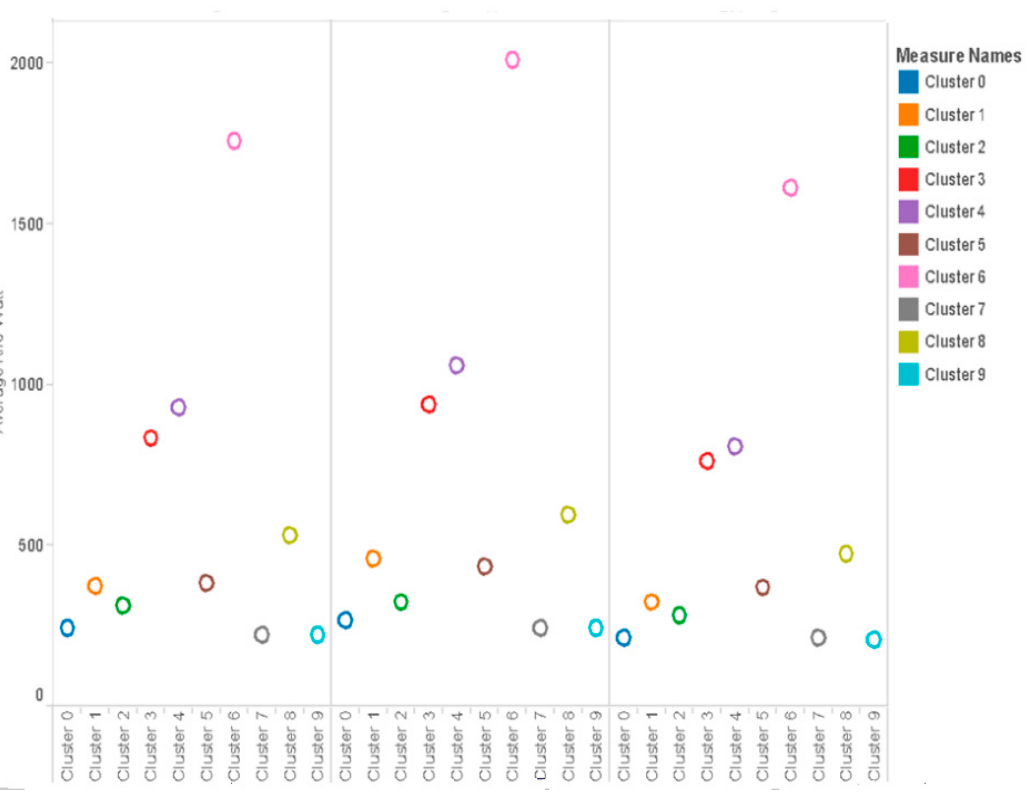
Figure 7. Average monthly kW for clusters.